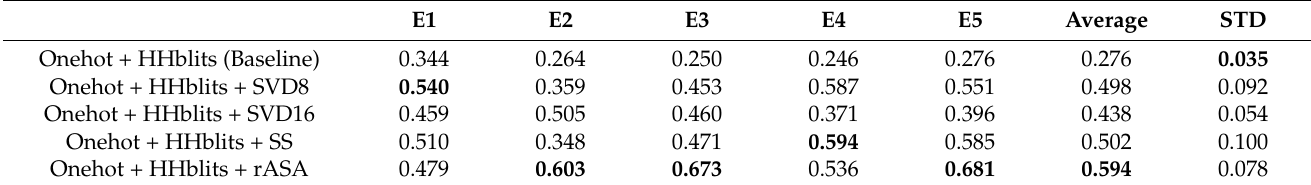
Table 3. Ablation study of AlphaFold2-derived features on single-sequence PPI site prediction.